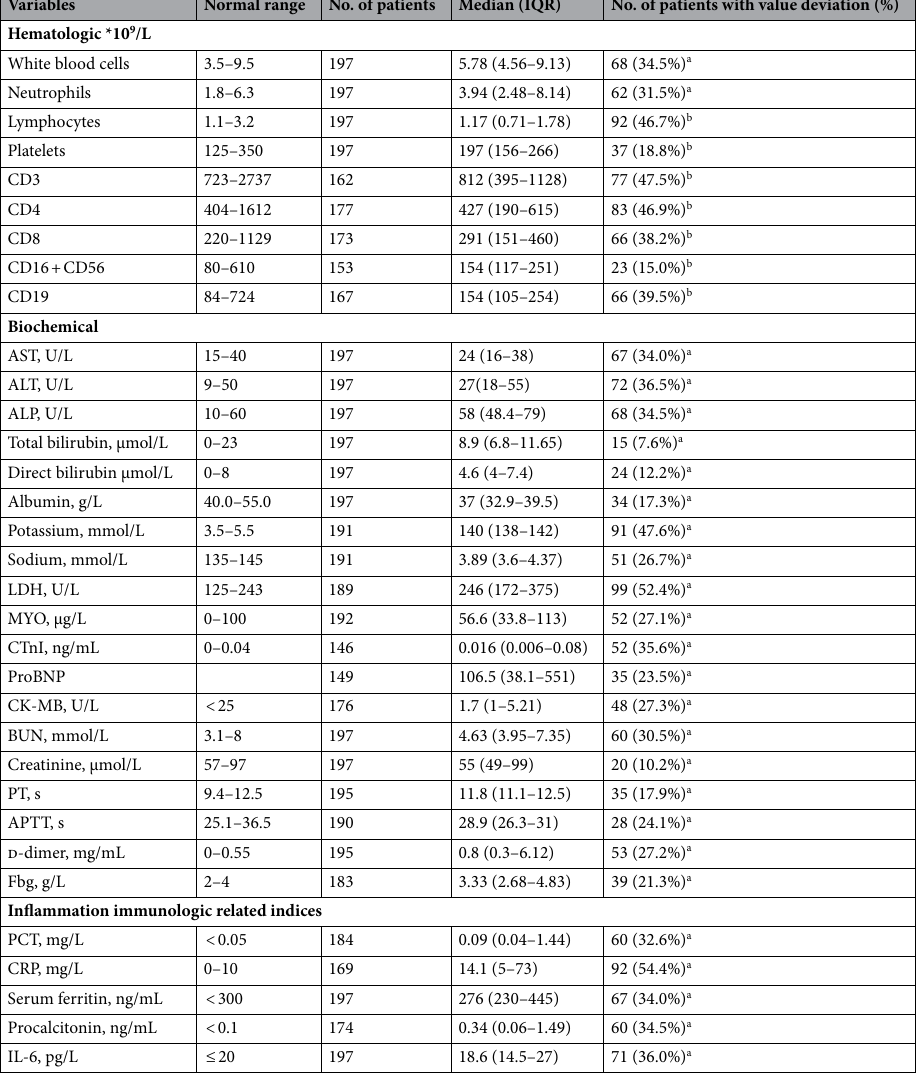
Table 3. Initial laboratory indices of patients with COVID-19. a Above reference. b Below reference. Data are median (IQR), n